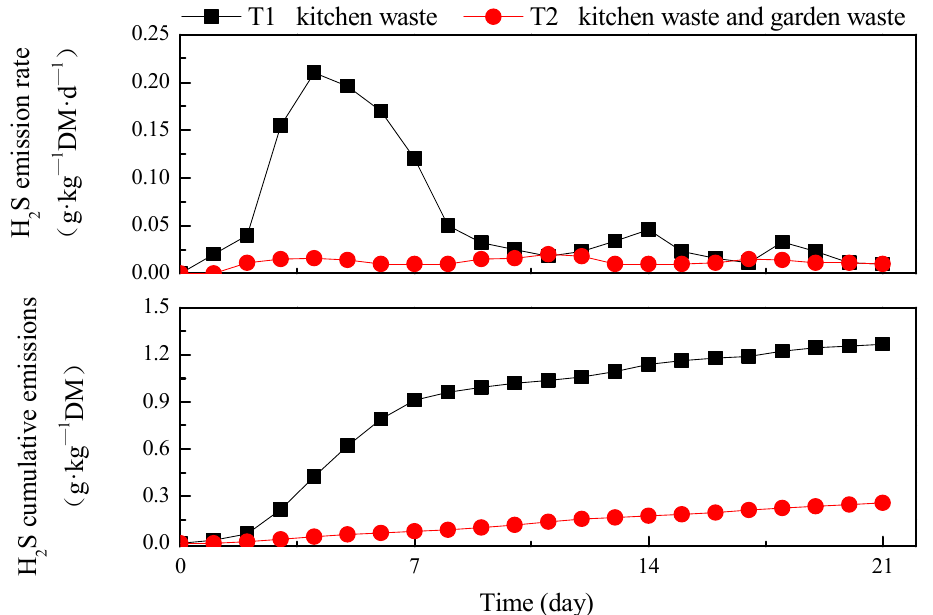
Figure 6. Evolution of H 2 S during composting.